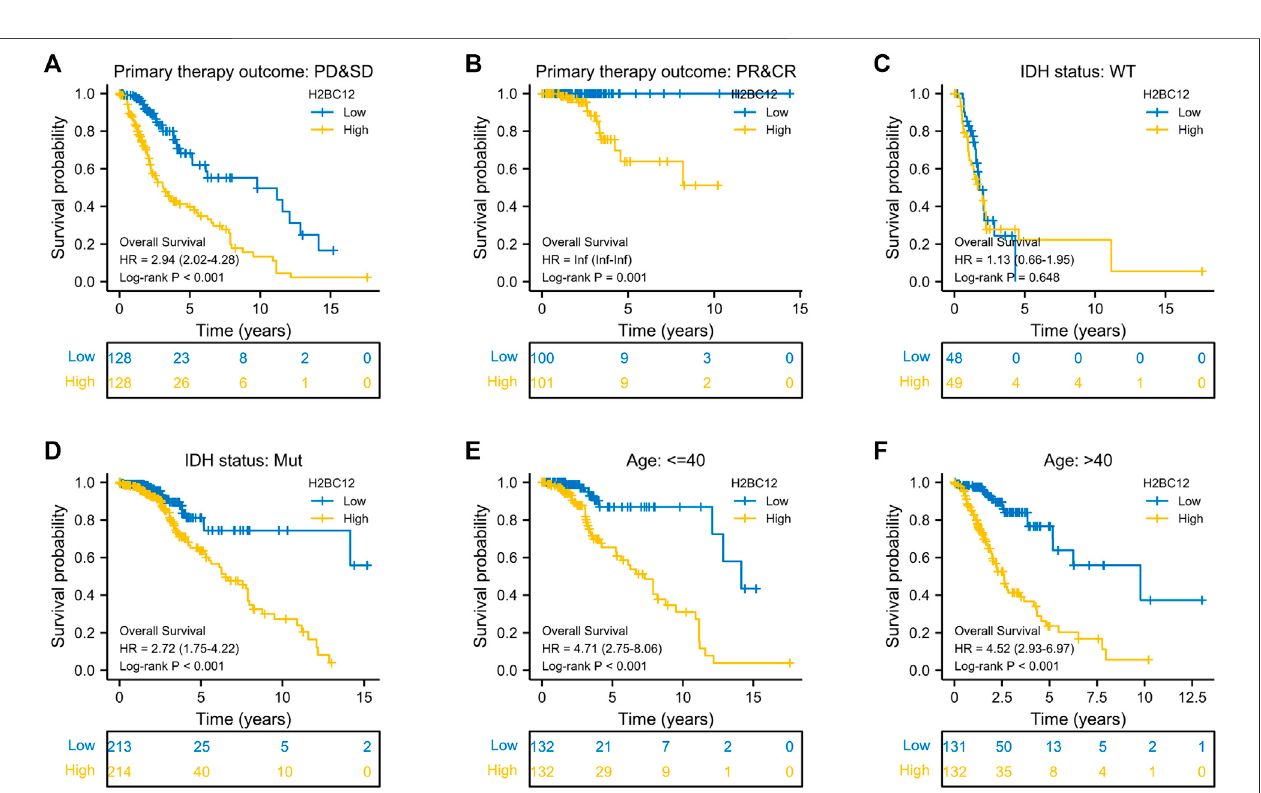
FIGURE4 | Clinical strati fi cation analysisof thesurvivaldifference in the high- and low-H2BC12 groups byprimary therapy outcome, IDH status, and age. Kaplan- Meiersurvivalcurvesofpatients inthehigh-andlow-H2BC12 groupswithineightclinicallystrati fi edsubgroups,includingprimarytherapyoutcome:PD&SD (A) ,primary therapyoutcome:PR&CR (B) ,IDHstatus:WT (C) ,IDHstatus:Mut (D) ,age < =40 (E) andage > 40 (F) ,respectively.Patientsinthelow-H2BC12 grouphadbettersurvival outcomes than those in the high-H2BC12 group across all clinically strati fi ed subgroups except the IDH status of WT (p < 0.01).